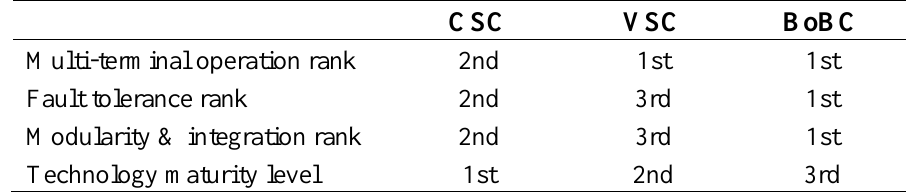
Table 12. Summary of converter qualitative characteristics for the candidate